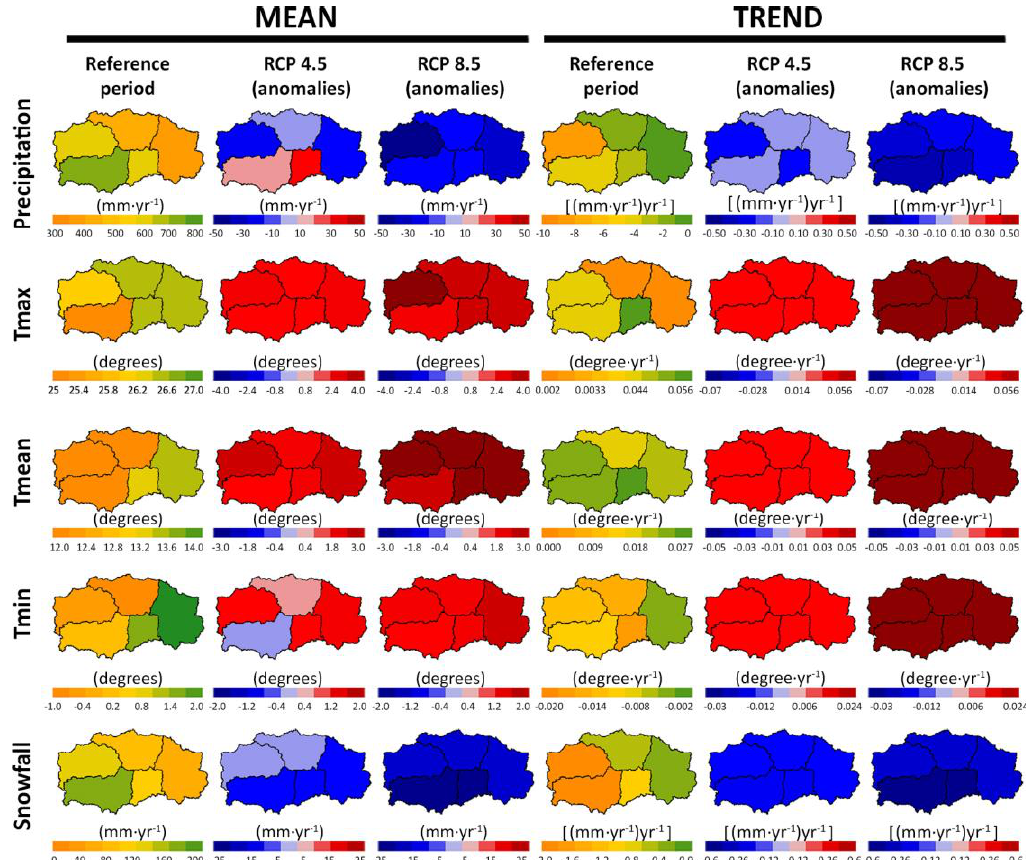
Figure 11. Regional distribution in Sierra Nevada of the mean annual values of the targeted variables in the study, together with their global mean trend during the 2006–2100 future study period for both RCP 4.5 and RCP 8.5 scenarios.